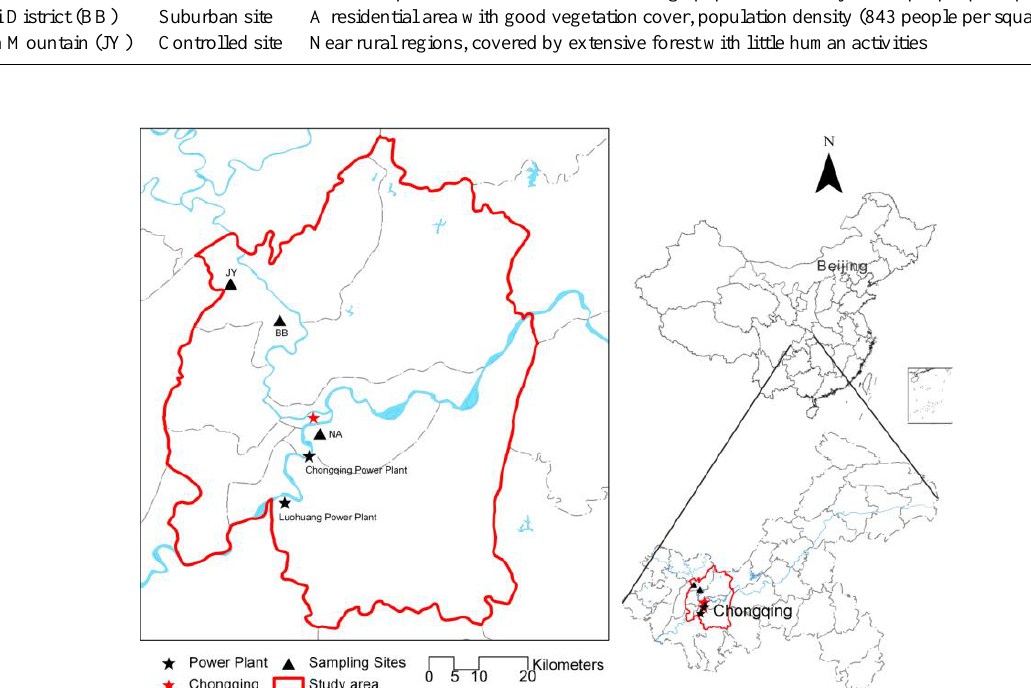
Fig. 1. The locations of study area and sampling